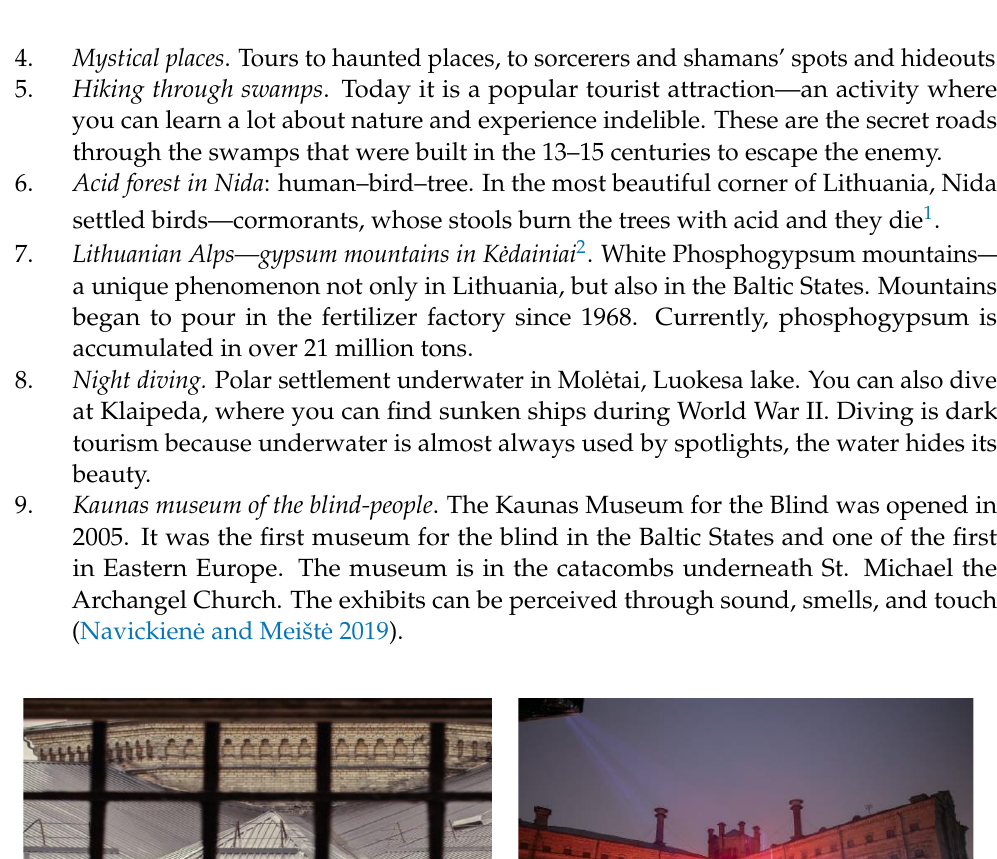
Figure 15. ( A ) Soviet bunker ‘House of Creation’. Available online: https://tinyurl.com/36kt673r